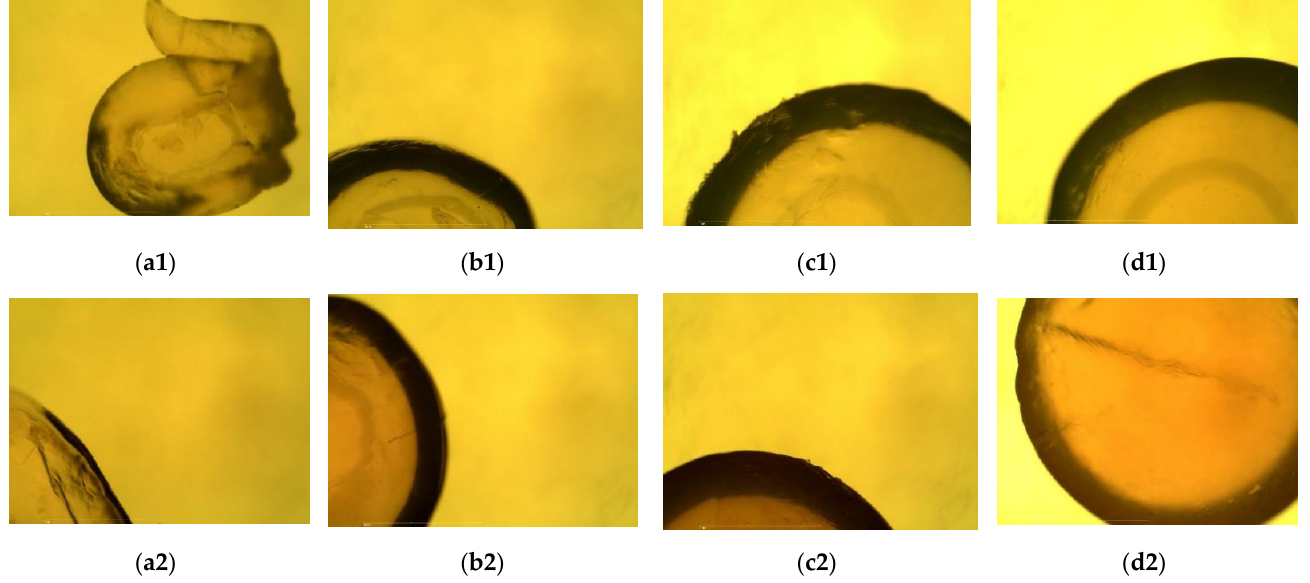
Figure 3. Micrographs of the bead cross-sections before (plain beads made with water) and after the adsorption process (beads with adsorbed dye): 1%, 2%, 3% and 4% plain beads before adsorption ( a1 – d1 ); 1%, 2%, 3% and 4% plain beads after adsorption ( a2 – d2 ).